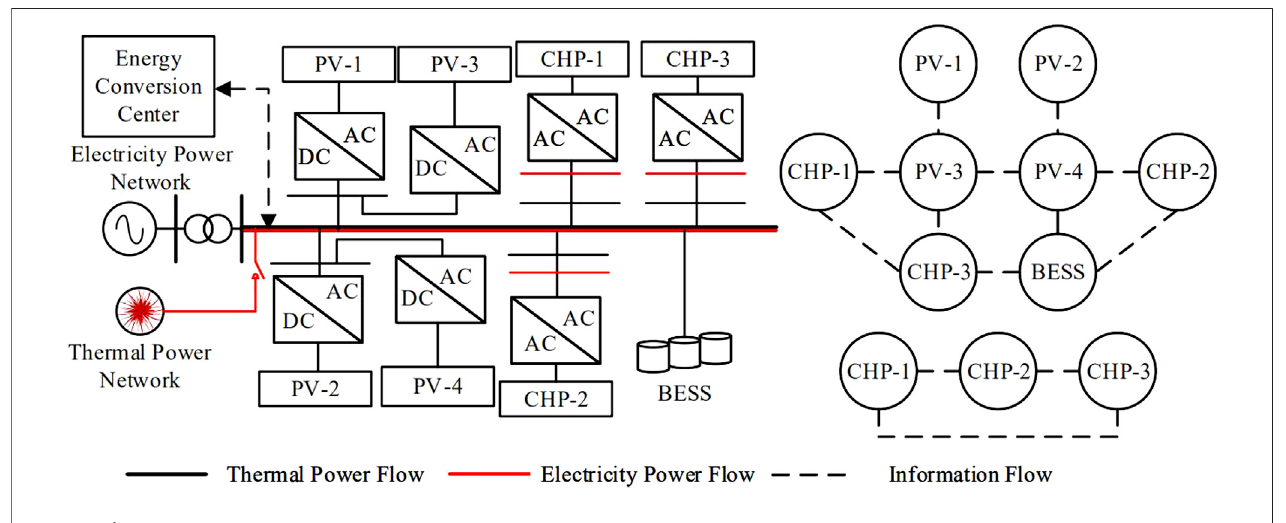
FIGURE 5 | Physical topology and information communication topology in the S-IES.